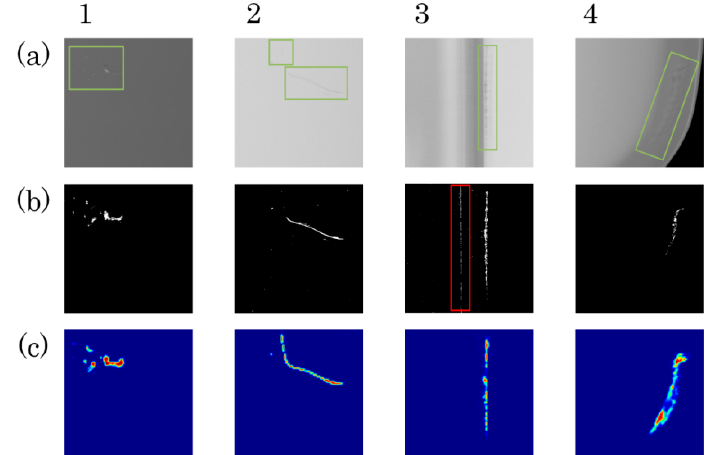
Figure 8. Results of the defect detection: ( a ) acquired defect images of the dent, discoloration, and scratch in the green dashed boxes; ( b , c ) are respectively segmentation result samples based on the classical machine vision method and proposed method; the non-defective speckle misjudged as the defect is shown in the red box.